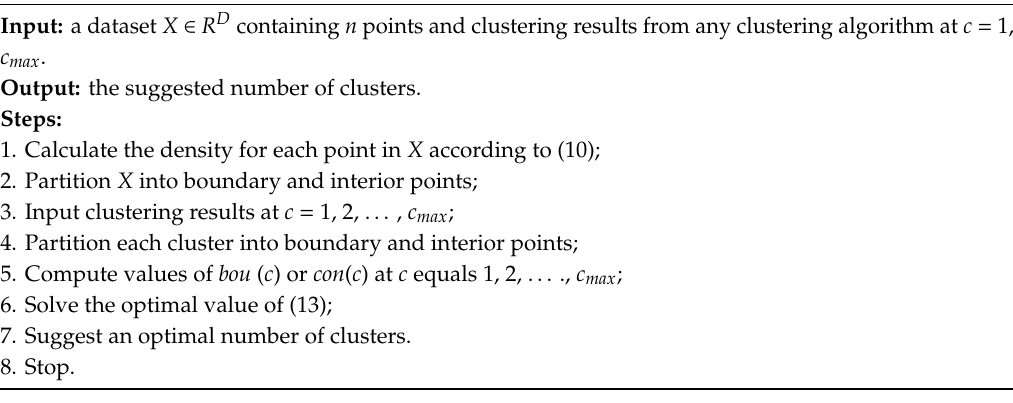
Algorithm 2. Evaluating Process Based on